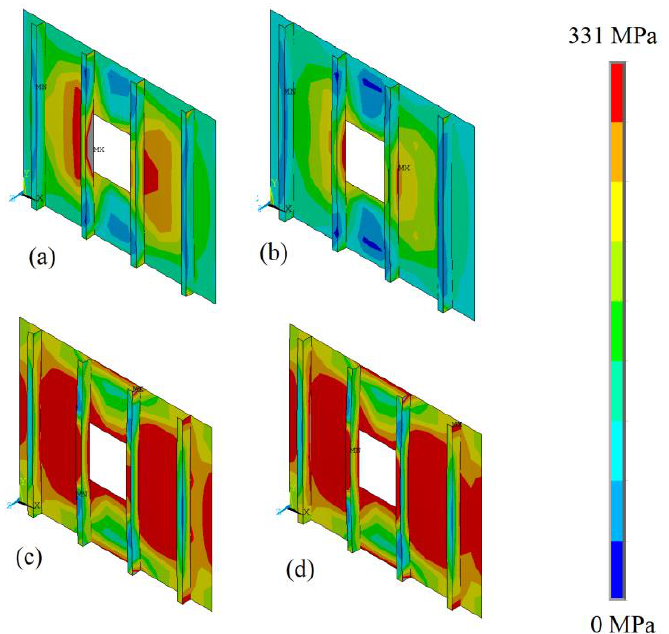
Figure 12. The von Mises stress distribution for the stiffened plate with centered square hole, with ( a ) t = 5 mm and Q = 2 q u /3, ( b ) t = 5 mm and Q = 5 q u /6, ( c ) t = 12 mm and Q = 2 q u /3, and ( d ) t = 12 mm and Q = 5 q u /6.